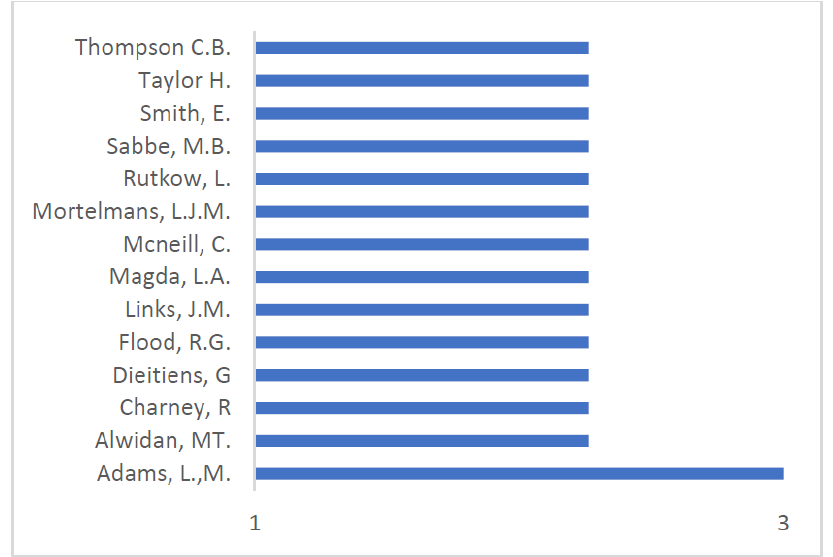
Figure 3. Ranking of main authors. Table 1. Patterns of authors, institution, research area, citations, and H-index (Scopus).